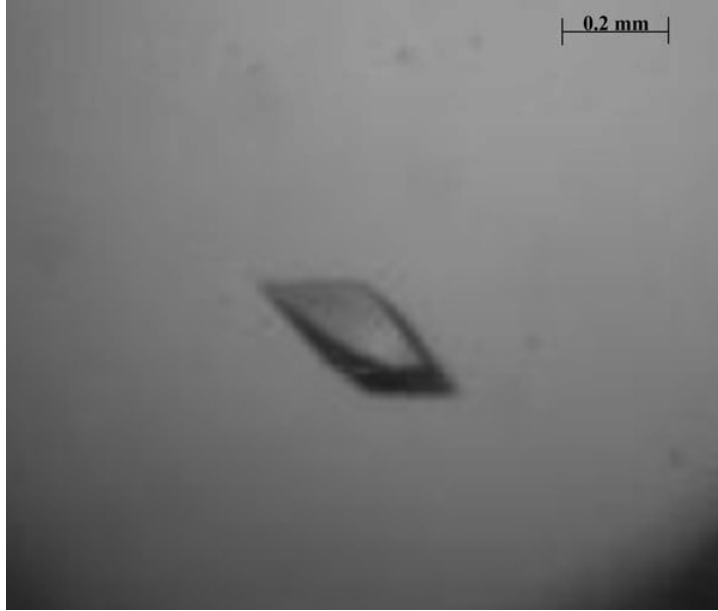
Figure 6. Crystal of lectin from the seeds of Dioclea wilsonii complexed with X-Man (5-Bromo-4-chloro-3-indolyl- α - D -mannopiranoside). The crystal belongs to orthorhombic space group